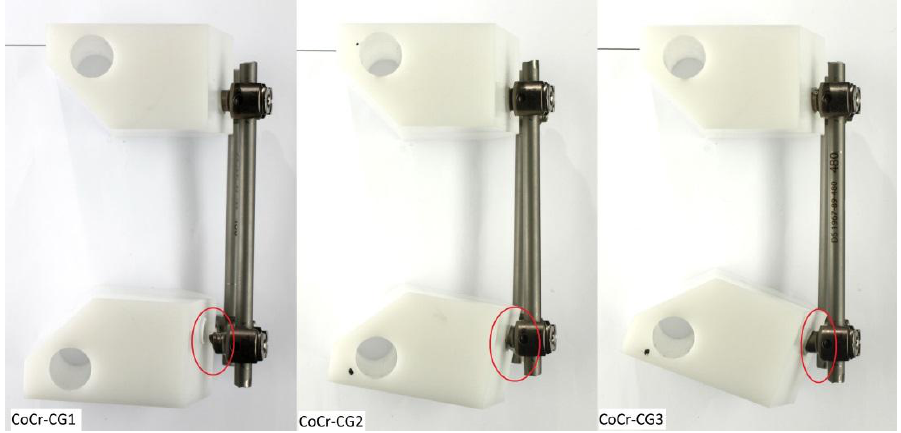
Figure 6. Microscopic analysis of fractured titanium rod after electrocautery (VHX-5000, Keyence, Osaka, Japan). ( a ) Post-fracture situation at the electrocautery mark. ( b ) Fracture surface with typical signs of fatigue fracture (beach lines and forced fracture area). The circle shows the location of crack initiation at the electrocautery mark.